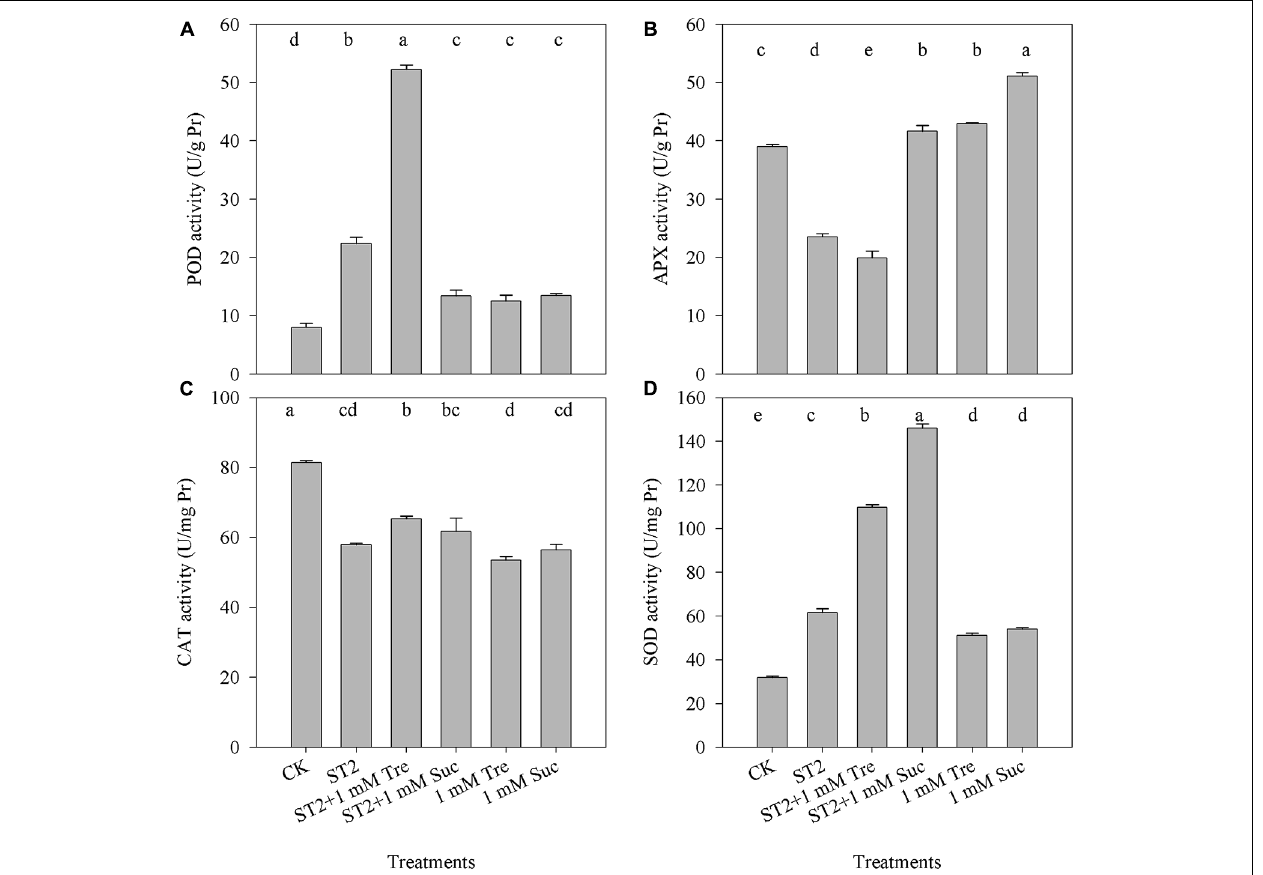
FIGURE 6 |The changes of leaf antioxidant enzyme activities occurring in the plants under control or high salinity conditions. (A) POD, peroxidase; (B) APX, Ascorbate peroxidase; (C) CAT, catalase; (D) SOD, superoxide